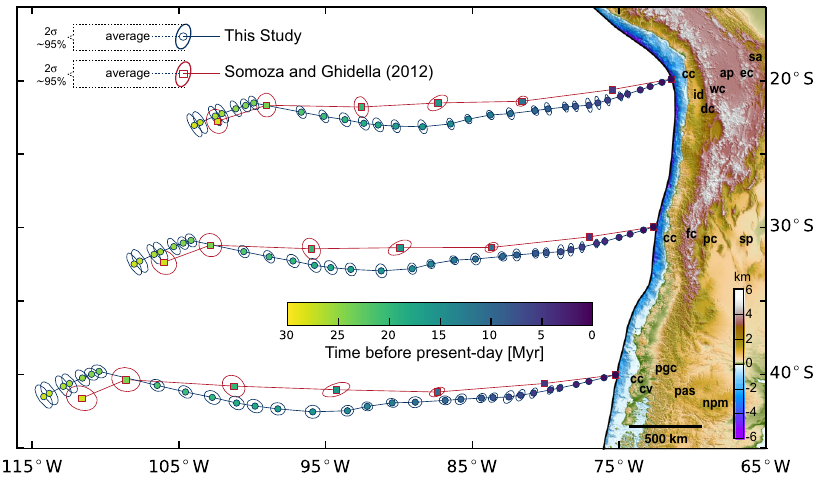
Fig. 1 Retro-projected trajectories for points of the Nazca plate relative to South America and topography of the Andean margin. We selected three points on the Nazca plate that are currently entering the trench axis at 20°, 30°, and 40°S, and show their retro-projected position as predicted by our kinematic reconstruction (circles with blue outline) and by Somoza and Ghidella (2012; squares with red outline). Colors for each point represent the average age of the respective stage rotation and the ellipses indicate their 95% con fi dence interval (i.e. two standard deviations = 2 s). The colored map shows the bathymetry and topography of the Andean margin east of the trench axis. Labels of morpho-structural units that form the anatomy of the margin are also used in Fig. 3 and are de fi ned as follow: cc Coastal Cordillera, id Intermediate Depression, dc Domeyko Cordillera, wc Western Cordillera, ap Altiplano, ec Eastern Cordillera, sa Subandean System, fc Frontal Cordillera, pc Precordillera, sp Sierras Pampeanas, cv Central Valley, pgc Patagonian Cordillera, pas Patagonian System, npm North Patagonian